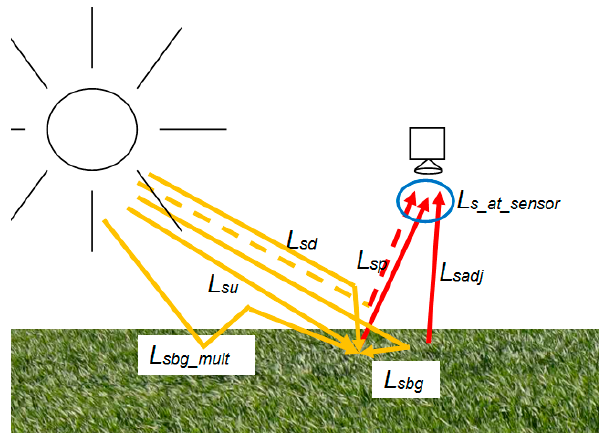
Figure 1. The at-sensor radiance ( L s_at_sensor ) components in sunny conditions include the surface- reflected direct solar radiance ( L su ), the reflected skylight ( L sd ), the reflected background radiance ( L sbg ), the multiple radiance reflected first by the background objects and then by the atmosphere ( L sbg_mult ), the radiance scattered from adjacent objects ( L sadj ) and the atmospheric path radiance ( L sp ) [23,24]. Corrections for the atmospheric and illumination conditions are required in order to transform image grey values (DN) to reflectance. In the classical physically based correction approach, a radiometrically-calibrated sensor is the prerequisite [23–25]. The fundamental calibration parameters